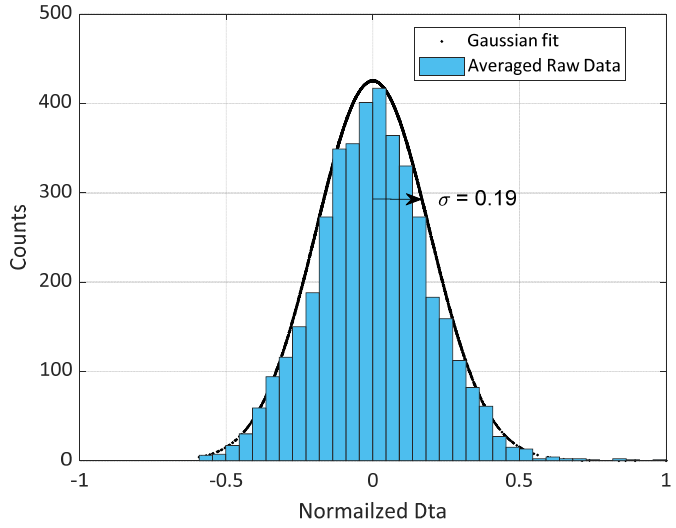
Figure 5. Noise of distribution and Gaussian fitting curve.